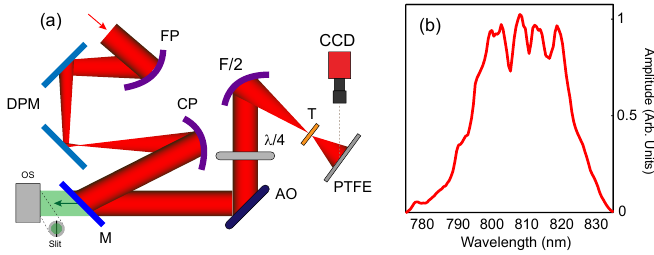
Figure 1. ( a ) Schematic of the experimental set-up. Key: FP—focusing parabola; DPM—double plasma mirror; CP—collimating parabola; M—mirror; OS—optical spectrometer; AO—adaptive optic; λ /4—quarter waveplate; F/2—off-axis parabolic mirror with F/2 focusing; T—target foil; PTFE—PTFE scatter screen for imaging the transmitted laser light; ( b ) Example measurement of the spectrum of the laser light before interaction, as made with an optical